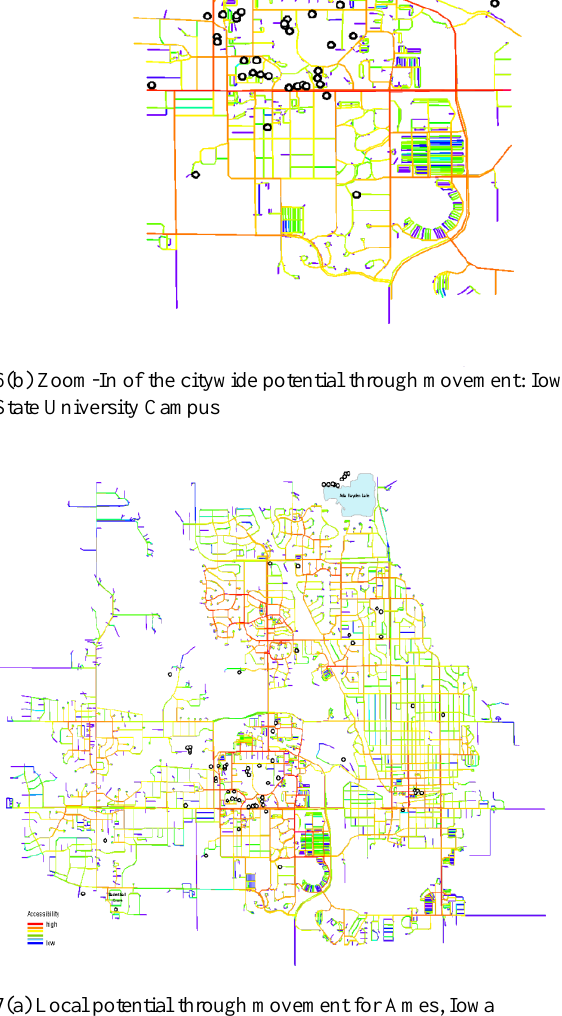
Figure 7(a) shows the local potential through movement “Normalized Choice local” (or NACH R low metrics 10%). Figure 7(a) depicts highly accessible neighbourhoods.